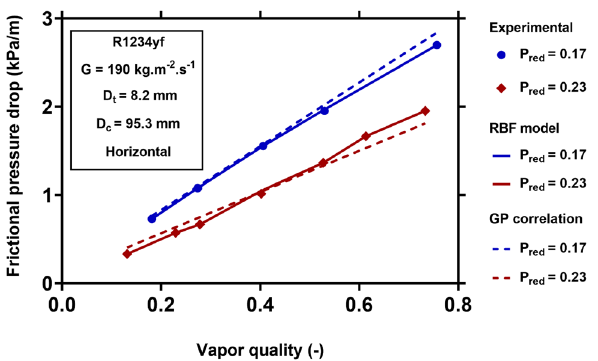
Figure 9. Effect of saturation temperature on the variation of two-phase FPD versus vapor quality. Comparisons of predictions of GP correlation (Eq. (20)) and RBF model with the corresponding experimental values 50 .